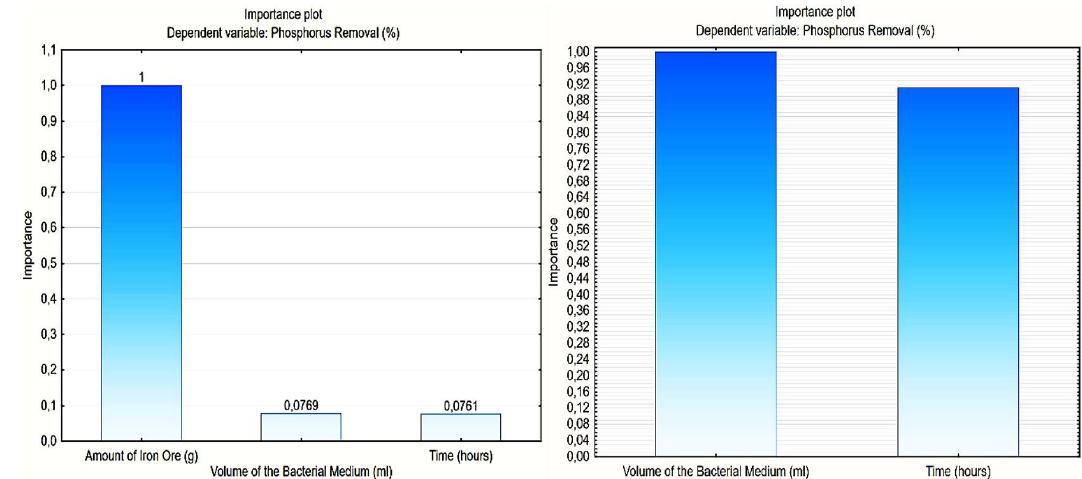
Figure 7. Importance plot of the variables evaluated on the reduction of the phosphorus content of the iron ore